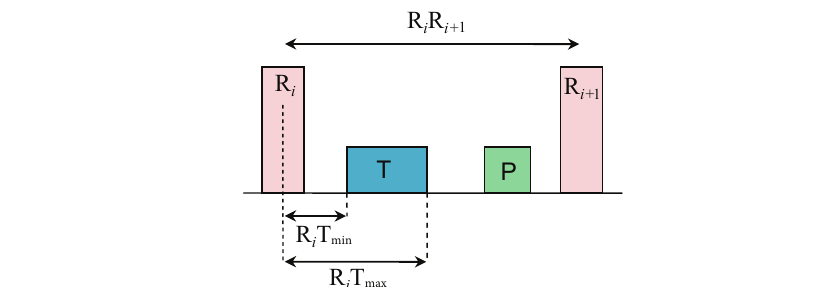
T ). Where R represents the minimum i +1 i min T represents the maximum interval i max